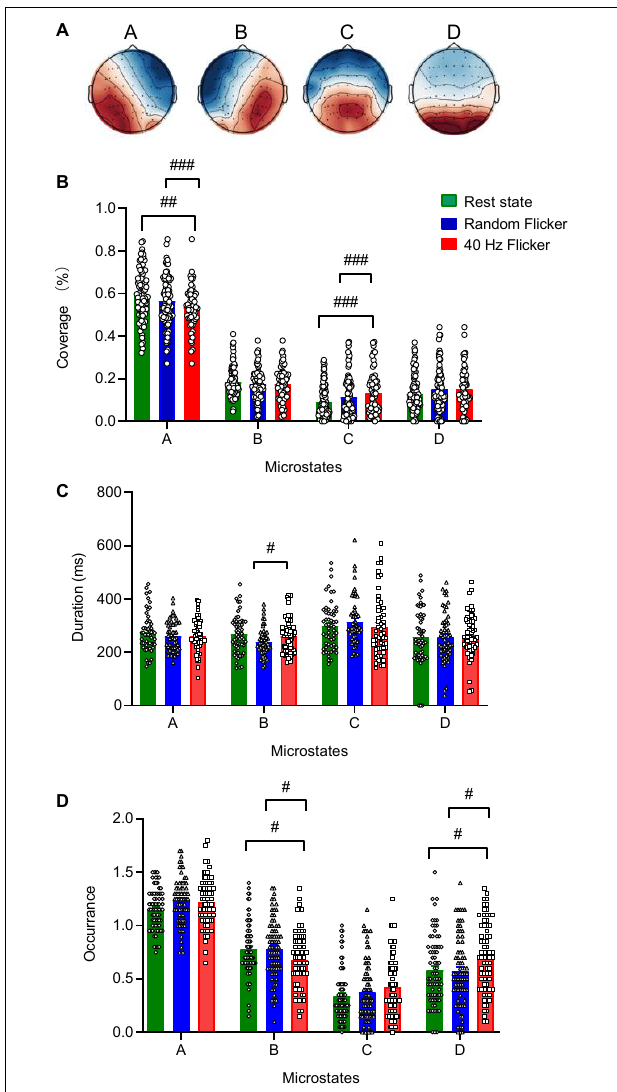
FIGURE 3 | Identification of microstate classes, coverage, duration, occurrence. Panel (A) The global maps were calculated based the aggregated dataset from all participants and were back-fitted to each of the EEG recordings. The labels (A–D) indicate the four microstate classes. The four microstate classes coverage (B) , duration (C) , and occurrence (D) were calculated and shown. Statistical comparisons between the three conditions (rest state, random flicker, and the 40 Hz light stimulation) were performed using one-way ANOVA with multiple comparisons using FDR correction using the two-stage linear step-up procedure of Benjamini, Krieger, and Yekutieli using GraphPad. Significant groups were shown in panel (B–D) . #, ##, and ### indicate the FDR adjusted P < 0.05, P < 0.01, and P < 0.001, respectively. Error bars are